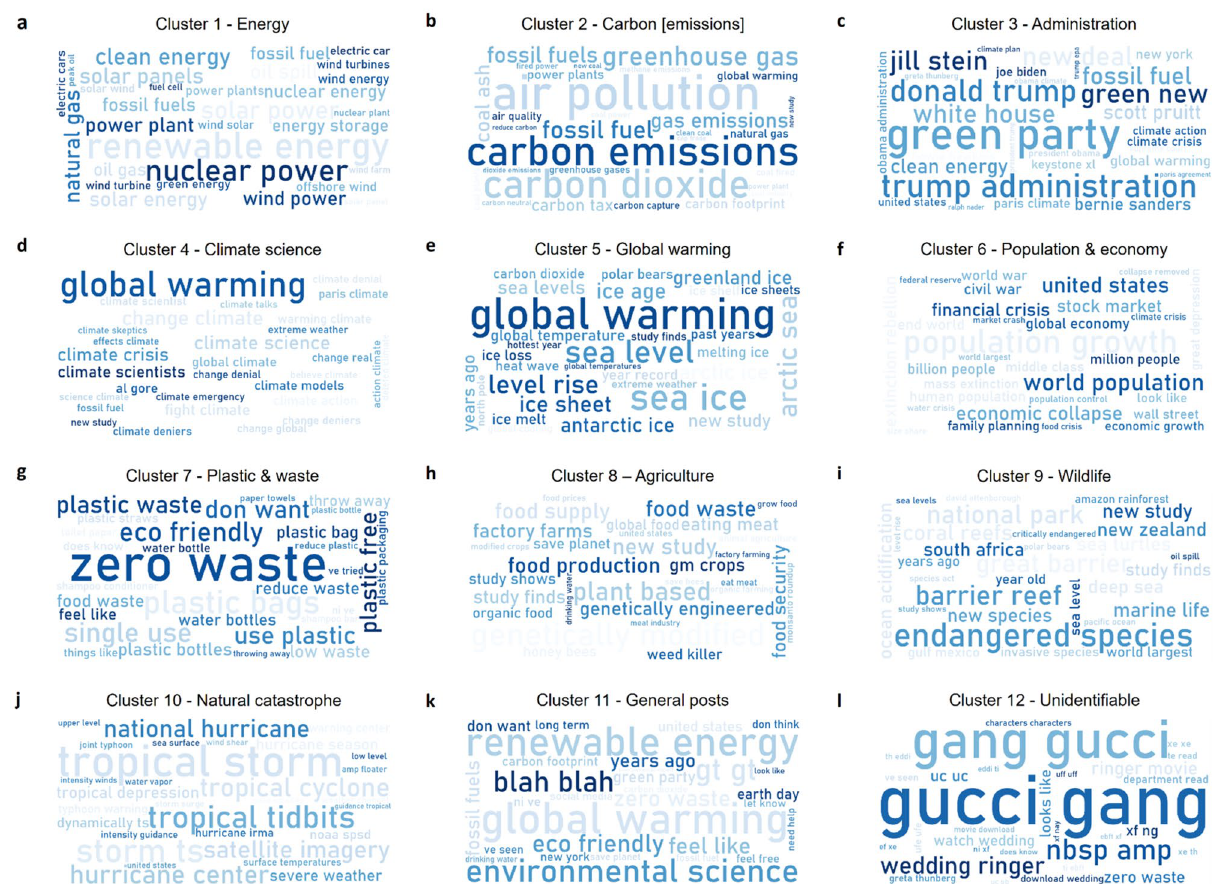
Figure 8. Sample 2 final optimized clusters in word clouds 50 . The word cloud for a given optimized cluster has been generated from top 30 bigrams 68 featured in that cluster sorted by Tfidf-Vectorizer 69 weights. It provides a bird’s view into the underlying keywords belonging to all 12 clusters ( a – l ), specifically showing how distinguished the optimized clusters are in terms of their composition and how similar they are when compared with Sample 1 (Fig. 7). We observe a distinct group of bigrams belonging to each optimized cluster in Sample 2 similarly as observed in Sample 1 thereby expressing the underlying theme distinctly for each cluster. The only difference between Sample 1 & 2 was observed in the Agriculture cluster ( h ), whereby we observe that while in Sample 2, bigrams are able to express the agriculture theme clearly, in Sample 1 (Fig. 7h), we observe a mix of bigrams from agriculture and administration themes, and so the agriculture-related posts also contain text related to administration. The same can also be observed from scatter plots (Fig 4a, c), where in Sample 1, a part of the Agriculture cluster highlighted in yellow is mixed up with the Administration cluster highlighted in black as opposed to Sample 2, where both of the clusters are clearly